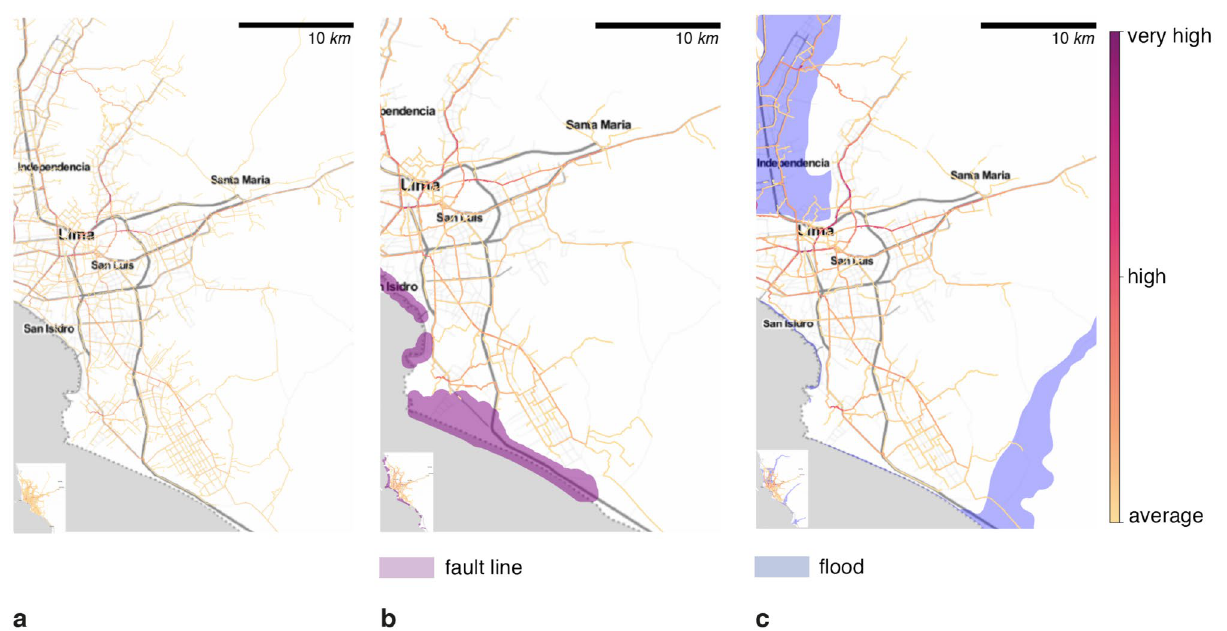
Figure 5. Criticality map for Lima road network infrastructure. Where ( a ) is the criticality in the undisrupted scenario, ( b ) is the criticality in the fault line scenario with a buffer of 500 m with a return period of 50 and 100 years, and ( c ) is the is the criticality flood scenario of flood planning hazard map at historical return period. ( b ) depicts the highest criticality in the main highway joining Lima north and south. (c) evinces a homogeneous degradation. Maps were created using Map Tiles by Stamen Design, CC BY 3.3 - Map data ©using Contextily 1.2.0 library for Python